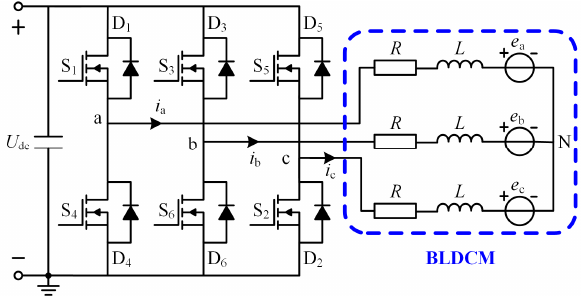
Figure 1. The equivalent model of the BLDCM drive system.